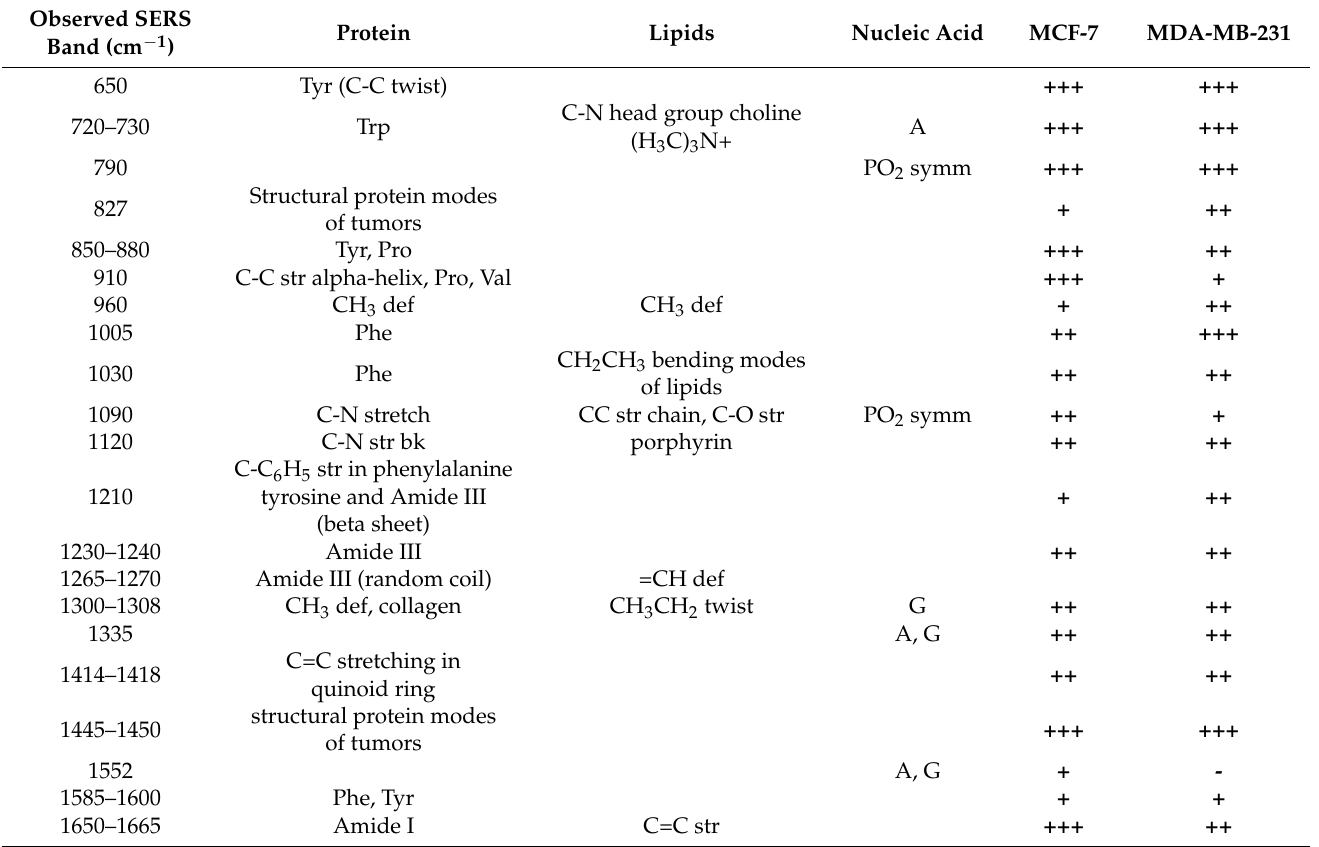
Table 2. Assignment of SERS bands depicted in Figure 8